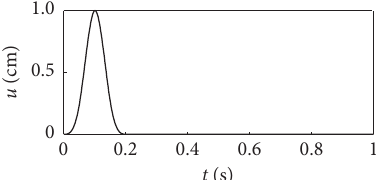
Figure 5: Time histories of the pulse wave.